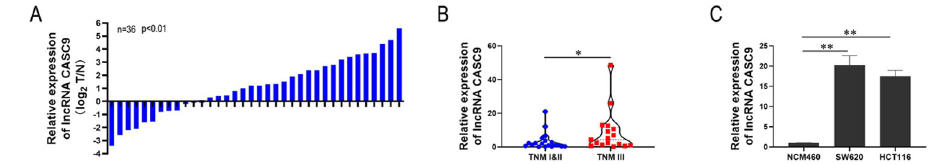
Fig 1. LncRNA CASC9 expresses highly in CRC. (A)The relative expression of lncRNA CASC9 of carcinomas and para-cancerous tissues from patients with CRC was determined by qPCR. Histogram of relative expression of lncRNA CASC9 (log 2 T/N) from 36 patients(n = 36), one histogram represents one specimen. Most of these values are positive (p < 0.01). (B) Subsets were defined as TNM I&II and TNM III from 36 carcinomas, relative expression of lncRNA CASC9 in two subsets were compared, and the expression in TNM III was significantly higher than that in TNM I&II. Each dot represents one carcinoma (n = 36). (C) Relative expression of lncRNA CASC9 in NCM460, SW620, and HCT116 are determined. Compared to NCM460, lncRNA CASC9 overexpressed both in SW620 and HCT116 cell lines. � P < 0.05 and �� P <